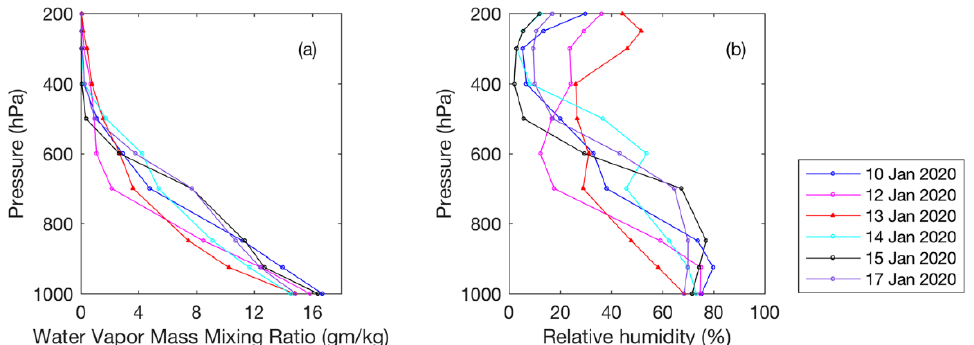
Figure 12. Vertical profiles before and after the eruption of the Taal volcano. a. AIRS water vapor mixing ratio. b. Relative humidity.